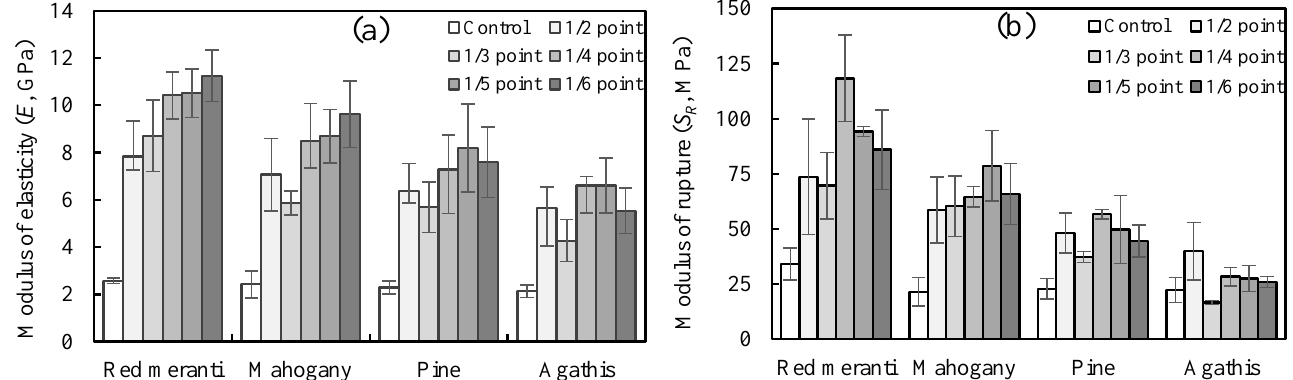
Figure 6. Flexural properties ( a ) modulus of elasticity ( E ) and ( b ) modulus of rupture ( S R ) of full-size specimens subjected to various concentrated loads (Note: control = center-point loading without lateral support; 1/2 point = center-point with lateral support; 1/3 point = third point with lateral support; 1/4 point = fourth point with lateral support; 1/5 point = fifth point with lateral support; 1/6 point = sixth point with lateral support).